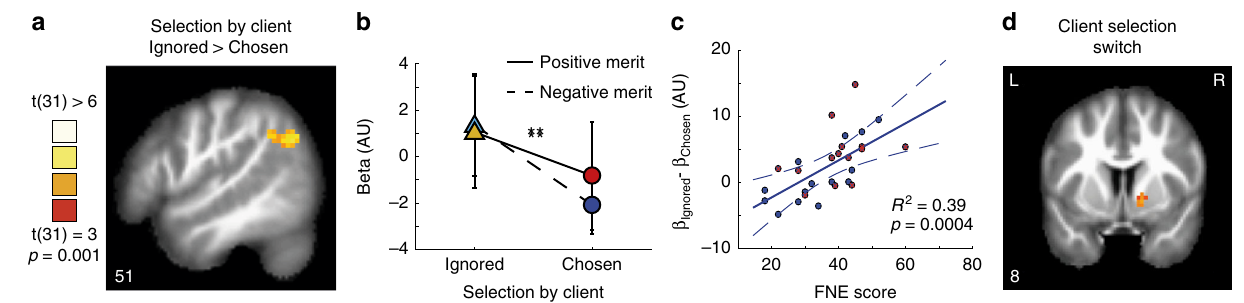
Fig. 4 Encoding of selection by client and client selection switch. a During the observation of evidence stage, activity in right TPJ (coordinates: [51, − 58,35]) was higher on ignored vs. chosen trials ( P < 0.001, FWE cluster size-corrected P < 0.05). b Analysis of beta estimates from the right TPJ showed a signi fi cant selection by client effect ( N = 32, F(1,94) = 11.4, P = 0.002). Error bars indicate 2 SEM. c Client selection effect on activity in the right TPJ was correlated with the participants ’ fear of negative evaluation (FNE) score: differences in rTPJ activity between ignored and chosen trials was greater for participants with high FNE score ( N = 28, as we obtained FNE scores from a subset of the participants. Red cross indicates female participants). Regression line is computed from the population-level estimate of the FNE scores on selection by client effect in the rTPJ. Dashed lines indicate 2 SEs. d At the evidence stage activity in VS followed client selection switches in adviser selection, i.e., higher when the client switched from the other adviser to you and lower when switched from you to the other adviser ( P < 0.005, FWE cluster size-corrected P < 0.05, see Figure S8 for uncorrected map